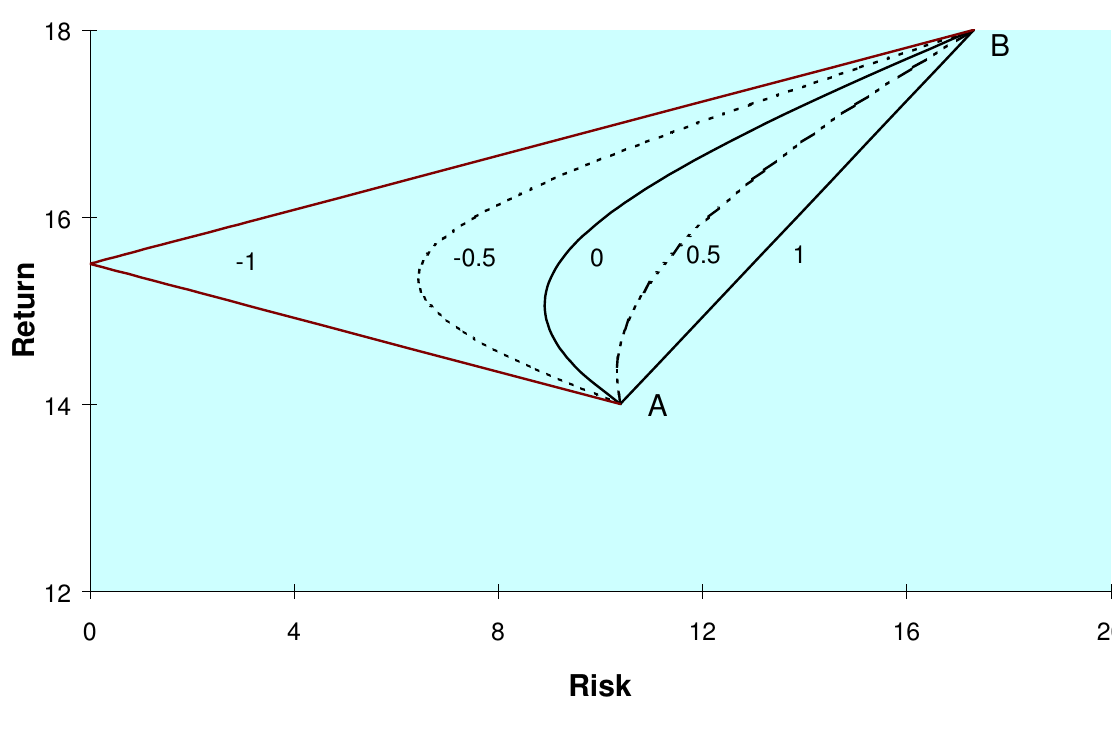
Figure 2: Correlation and